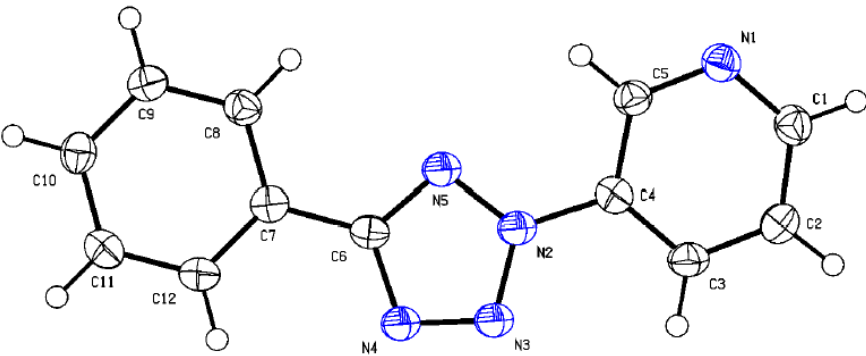
Figure 4. Molecular model of 3-(5-phenyl-2 H -tetrazol-2-yl)pyridine 1 with the numbering of atoms. Obviously, two different rotamers, which were formed by the rotation of the pyridine heterocycle through the N2-C4 bond, are possible for compound 1 (Figure 5).